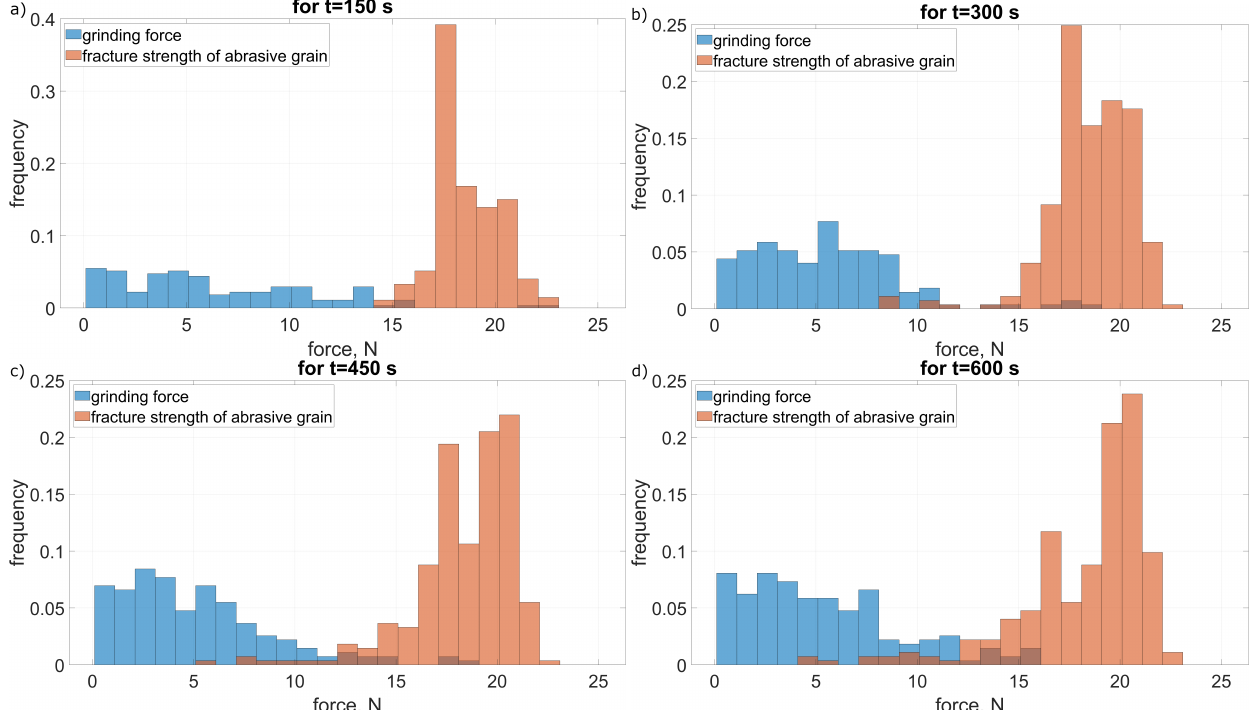
Figure 10. Grinding forces distribution F z (Equation (15)) and fracture strength w z (Equation (16)) of the abrasive grain for high grain fracture (pull-out) intensivity at: ( a ) 150 s, ( b ) 300 s, ( c ) 450 s and ( d ) 600 s of grinding